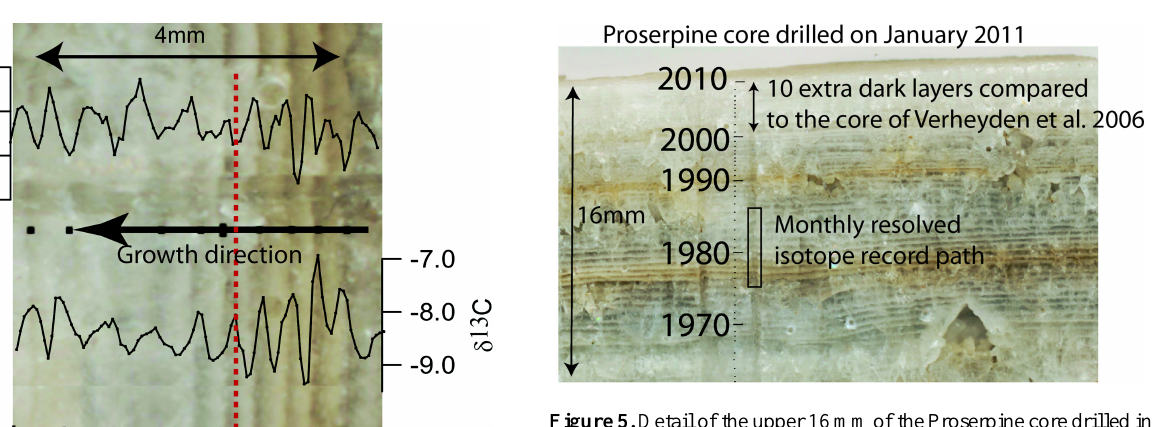
Figure 5. Detail of the upper 16mm of the Proserpine core drilled in 2011. Ten additional dark layers are counted compared to the core of Verheyden et al. (2006), confirming the seasonal character of the layering. Ages are based on layer counting, with one dark and one white layer deposited every year. The frame indicates the location of the monthly resolved δ 18 O and δ 13 C